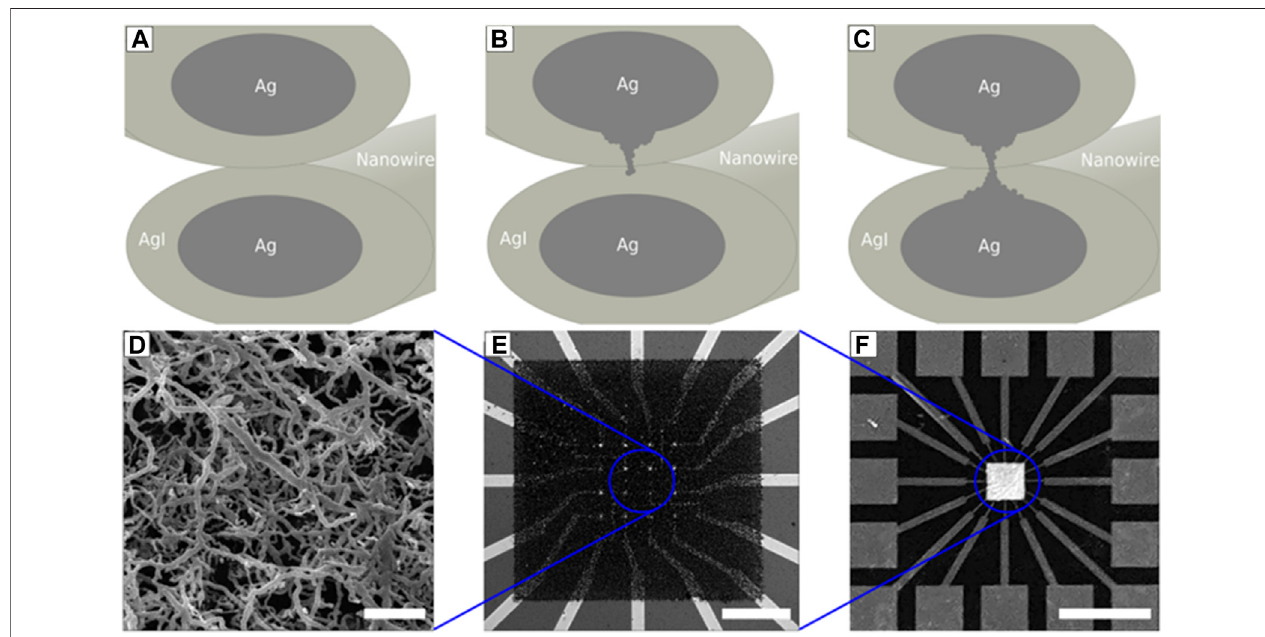
FIGURE 1 | Schematic diagram of an AgI-based ASN device, from nanowire junction to chip. (A) initial high resistance state of the system. (B) fi lament formation process under an applied bias (C) completed silver fi lament short circuits between overlapping nanowires (low resistance state). Yellow-gray represents AgI. Dark-gray represents Ag. Filament formation occurs as a gapless junction between Ag nanowires. (D) SEM image of the interconnected nanowire (scale bar (cid:2) 20 um). (E) Optical image of microelectrode array at center of the ASN device (scale bar (cid:2) 360 um). (F) Optical image of a complete 16-electrode ASN device (scale bar (cid:2) 5 mm).